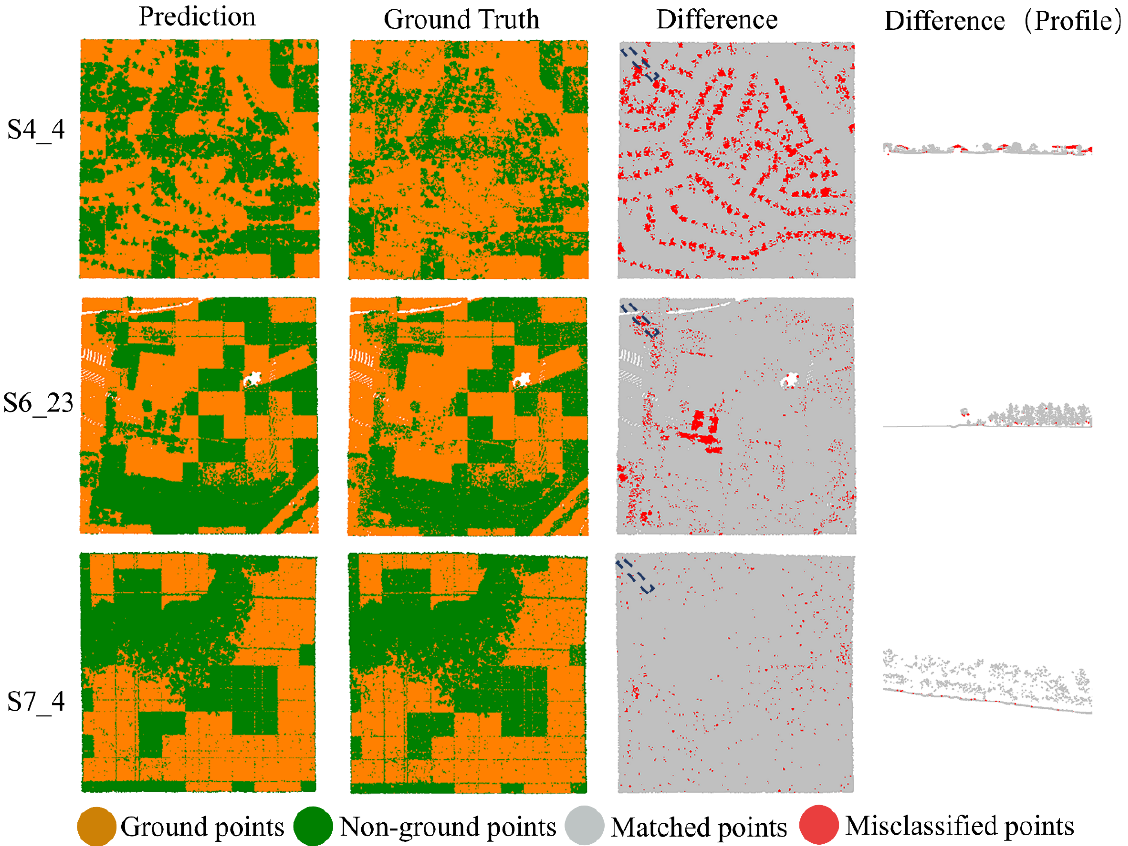
Figure 6. Ground filtering results of the Terrain-net on an additional third-party dataset. The dashed box in the Difference map indicates the location of Difference (Profile).